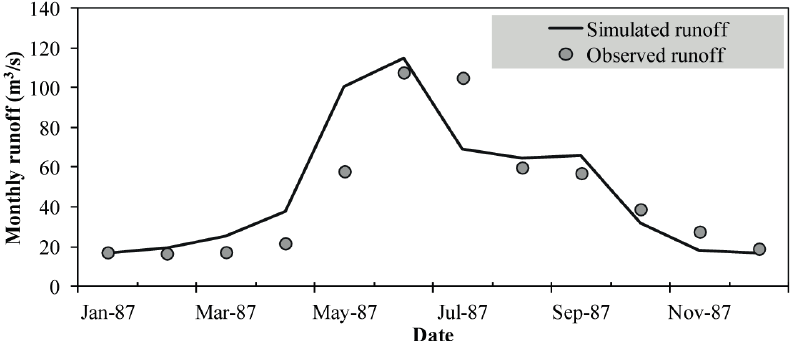
Fig. 4 Comparison of simulated and observed runoff for validation period.